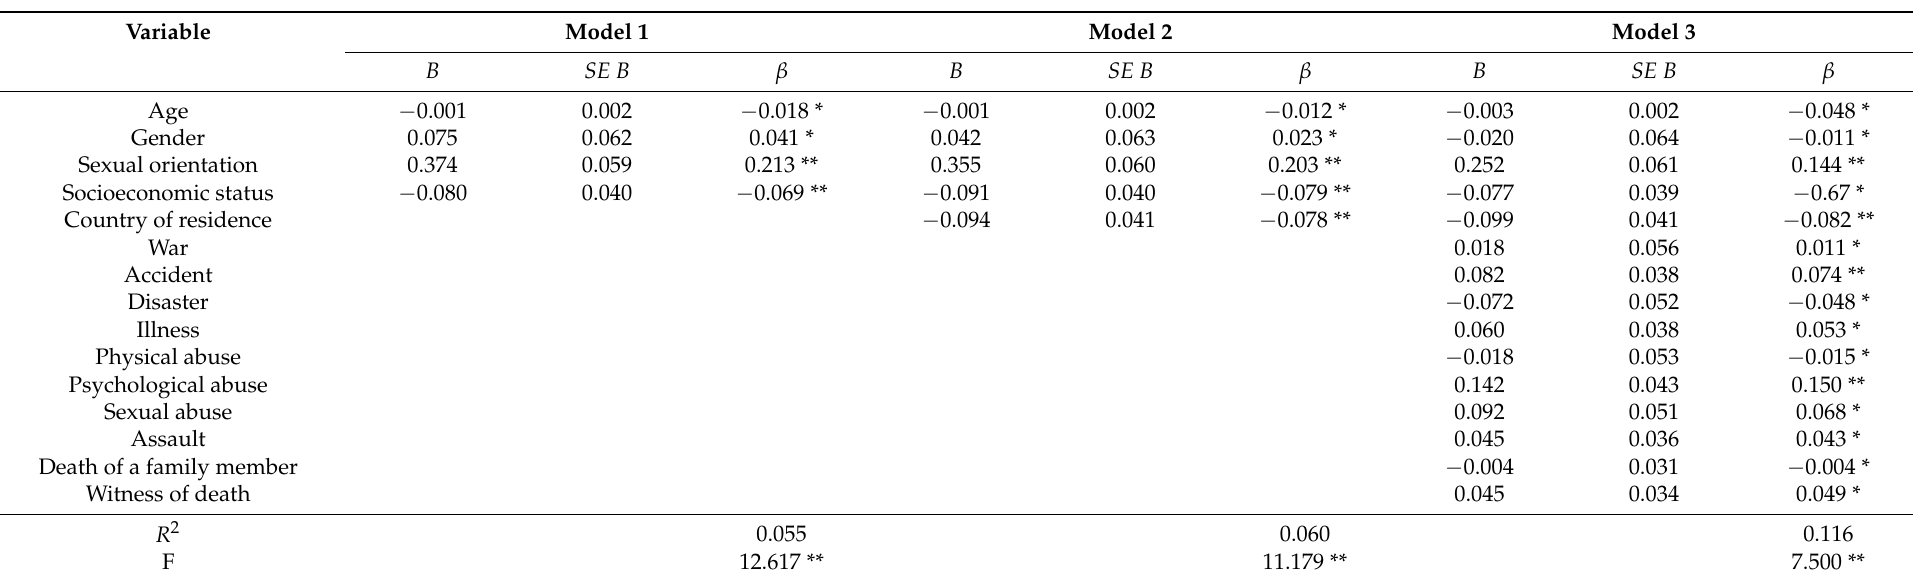
Table 6. Hierarchical linear regression analysis predicting the probability of committing